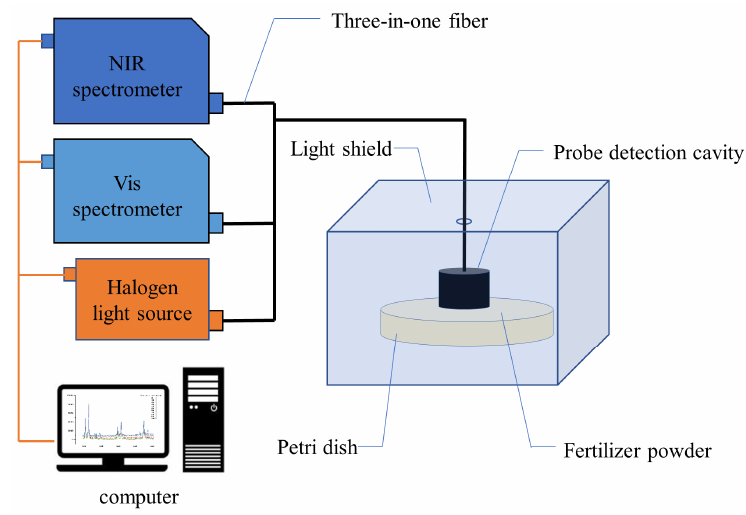
Figure 2. Spectral acquisition instrument.